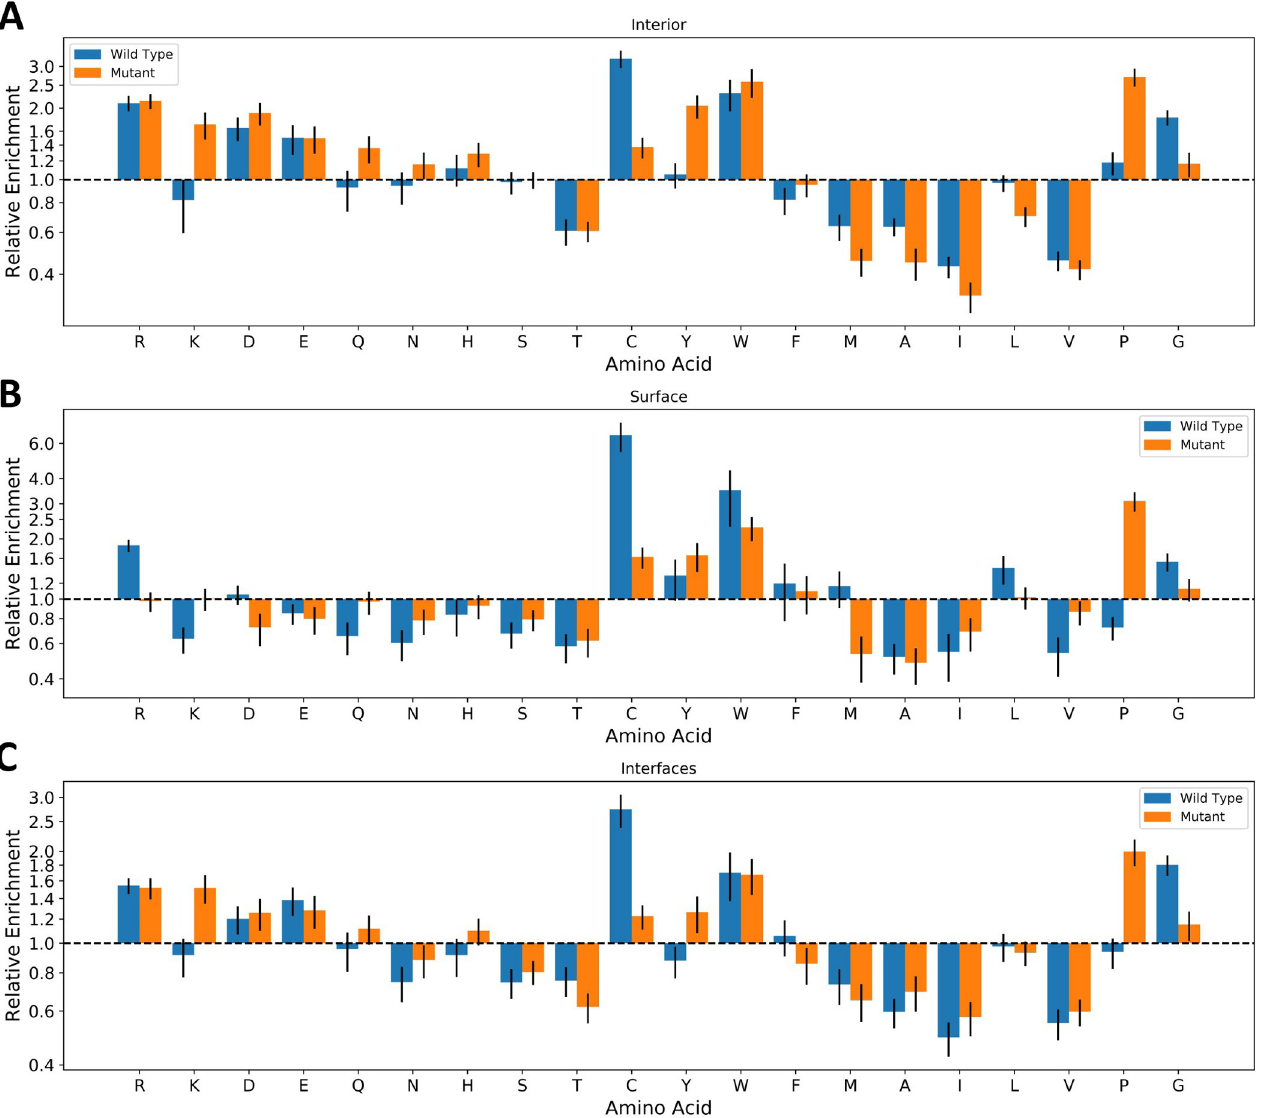
Fig 5. Enrichment of pathogenic variants at specific residues at different locations. The odds ratio of pathogenic mutations associated with specific amino acid mutations at A) the protein interior, B) the protein surface and C) protein interfaces. Blue bars represent mutations from a specific amino acid, while orange bars represent mutations to a specific amino acid. All error bars represent 95% confidence intervals. Detailed relative enrichment data is available in S1 Table.